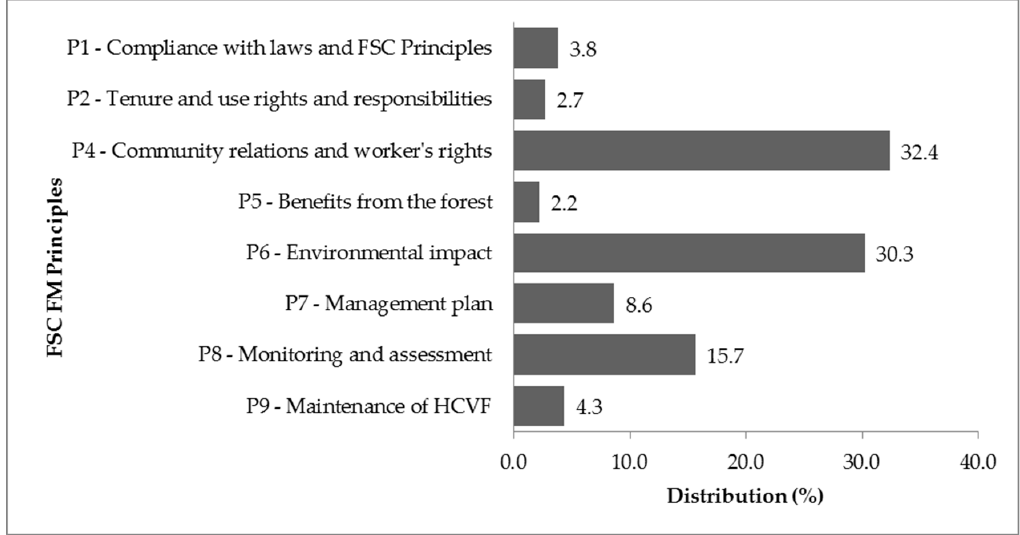
Figure 1. The distribution of non-conformities by FSC principles.